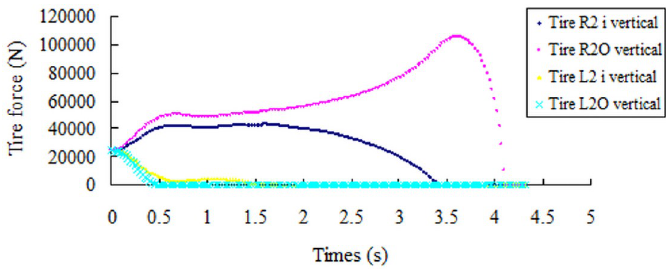
Fig 17. Vertical reaction curve of the rear axle tire with a friction coefficient of